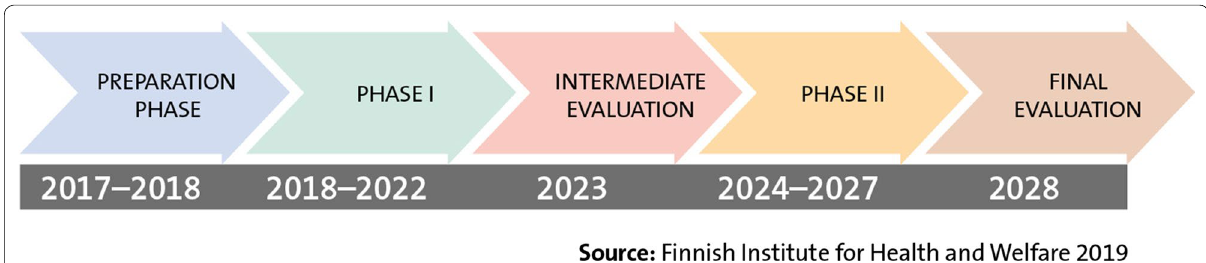
Fig. 13 Design and evaluation of the programme, and phasing of its